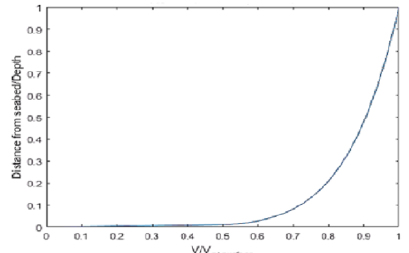
Fig. 8 Current velocity profile (non-dimensionalized with respect to the surface velocity) with depth (non-dimensionalized with respect to depth). Assumed velocity profile used in the theoretical estimations of tidal kinetic energy at San Jose The floats were slightly submerged and there was no influence of wind or wind waves during the campaigns, (September 15 and December 15, 2018), wind velocities were under 20 km/h, and wind wave heights outside the harbour were less than 0.75 m [44]. Under these conditions, float measurements have an accuracy within 10 %. Current